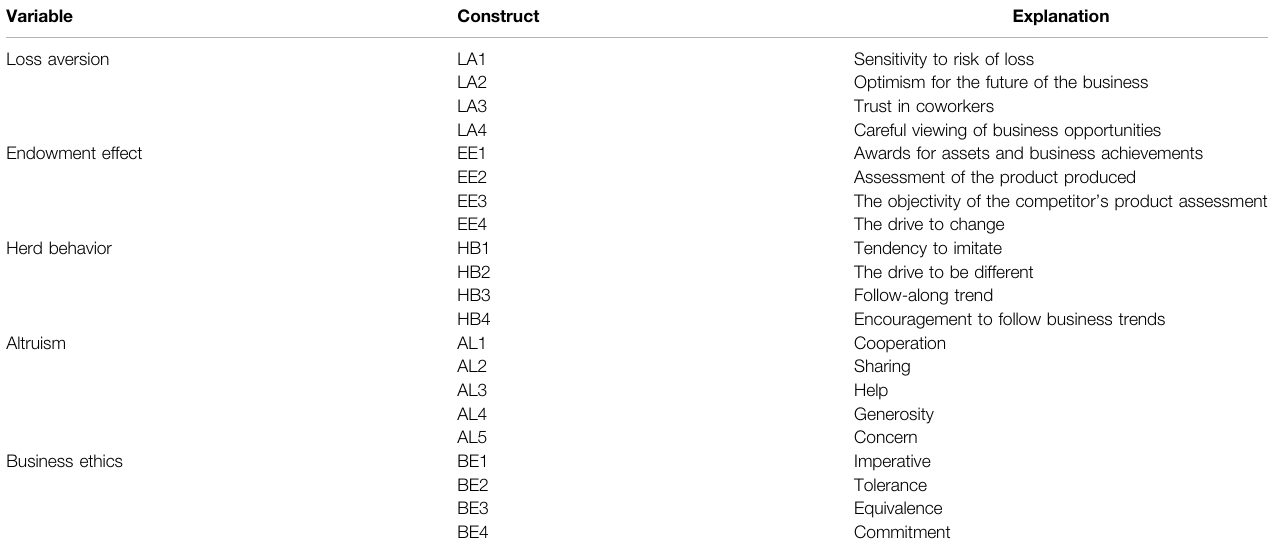
TABLE 1 | Research instrument.